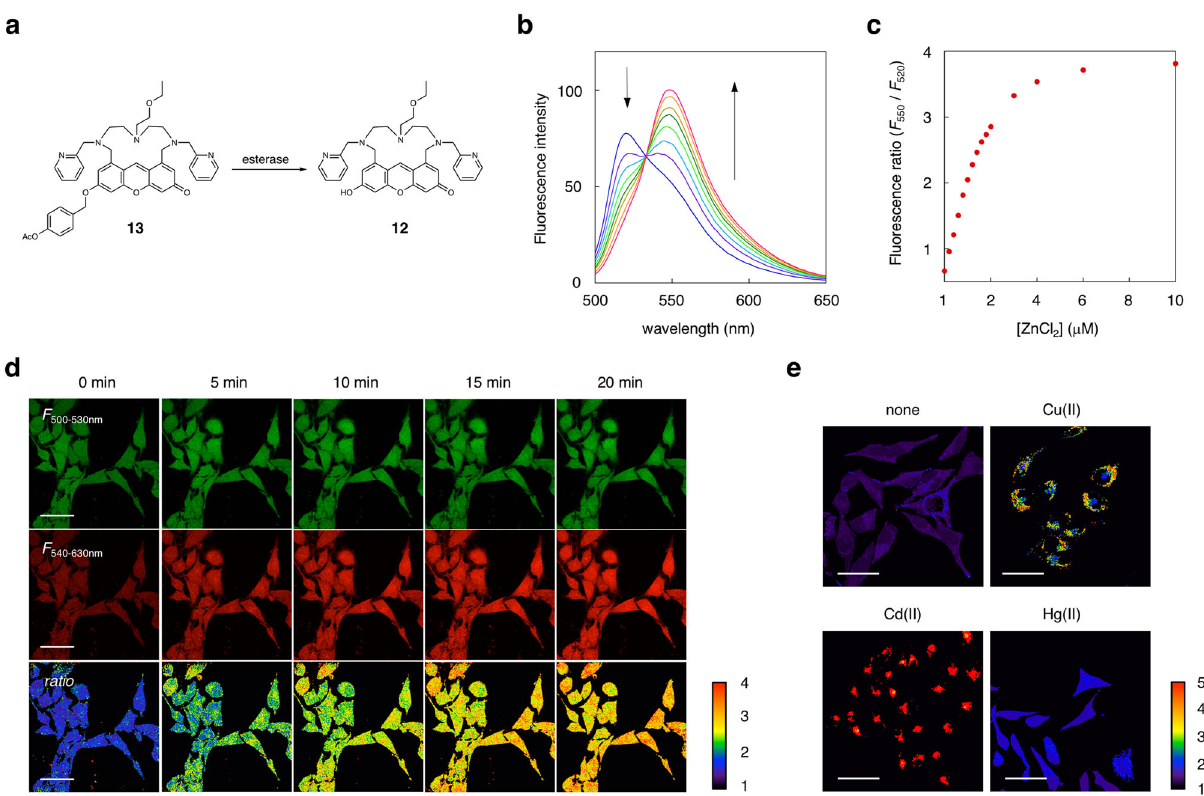
Fig. 7 Ratiometric fl uorescent detection of metal ions in living cells. a Structures of probe 12 and 13 . b Fluorescence spectral change of 12 upon the addition of ZnCl 2 . Measurement conditions: [ 12 ] = 1 μ M, [ZnCl 2 ] = 0, 0.2, 0.4, 0.6, 0.8, 1.0, 1.4, 2 μ M, 50 mM HEPES 100 mM NaCl, pH 7.4, 25 °C, λ ex = 488 nm. c Plot of the fl uorescence intensity ratio ( F 550nm / F 520nm ) of 12 upon the addition of ZnCl 2 . d Time-lapse images of Zn(II) inside HeLa cells. The cells were incubated with 13 (5 μ M) followed by the treatment with ZnCl 2 (5 μ M) in the presence of pyrithione (100 μ M). The ratio images were obtained from the imaging data acquired at two detection channels ( F 540 – 630nm and F 500 – 530nm ). Scale bar: 50 μ m. e Ratiometric detection of various metal ions in HeLa cells. The fl uorescence images were acquired at 5 min after the treatment of the cells with each metal ion (5 μ M) in the presence of pyrithione (100 μ M). Scale bar: 50 μ